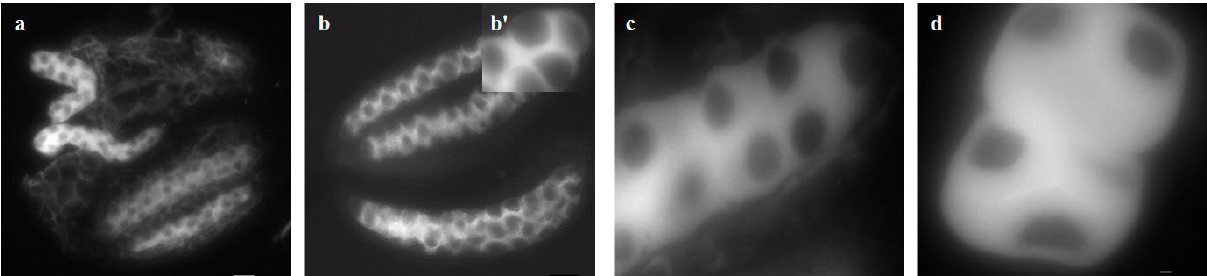
Fig. 3. Callose deposition in Limonium ovalifolium and L. algarvense . a Anther from a flower bud at stage II with callose labelling in L. oval- ifolium (bar = 50 µm); b Anther from a flower bud at stage II exhibiting bright fluorescence in L. algarvense (details shown in the inset – b ’) (bar = 50 µm) ; Tetrads with strong labelling in L. ovalifolium ( c ) and in L. algarvense ( d ) (bar = 5 µm).